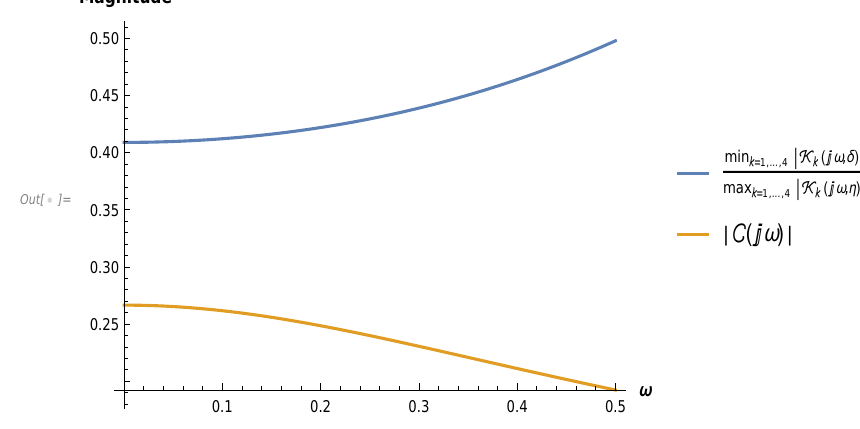
( j ω , δ ) / max k | k = 1,...,4 |K